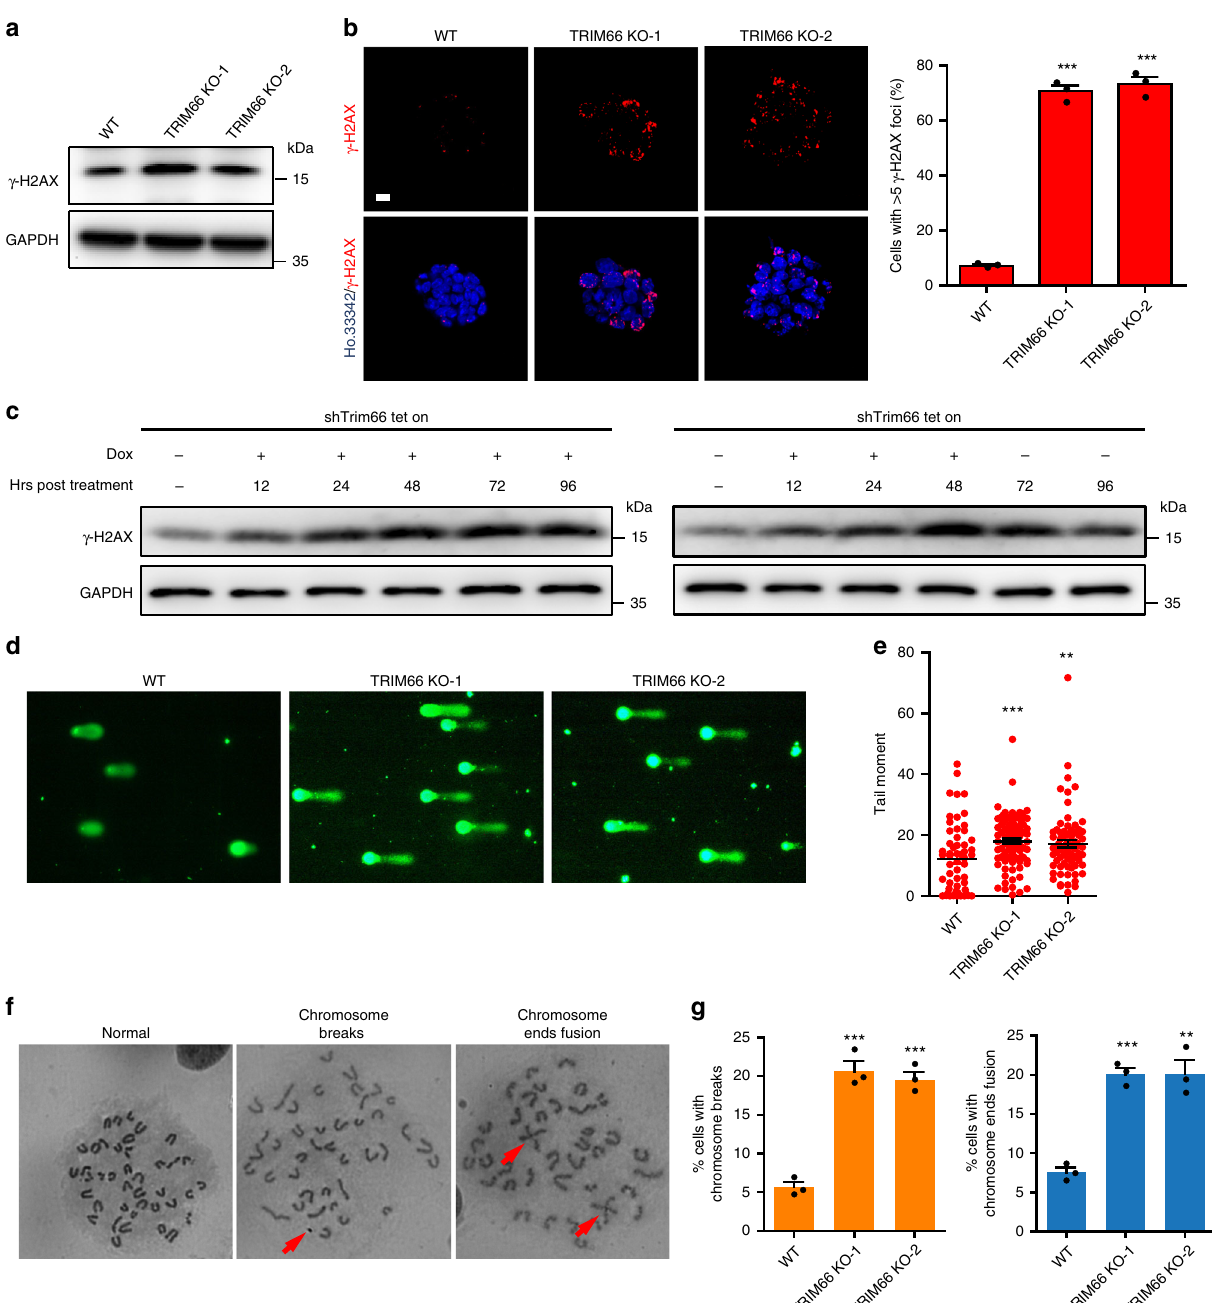
Fig. 3 Loss of TRIM66 leads to severe DNA damage and genomic instability in ESCs. a Immunoblot analysis showing the levels of γ -H2AX in WT and TRIM66-KO ESCs. b The formation of γ -H2AX foci in WT and TRIM66-KO ESCs. Representative immuno fl uorescence images (left) and the quanti fi cation (right) are shown. Scale bar, 10 μ m. More than 200 cells are examined in each sample. c The levels of γ -H2AX are detected by immunoblot analysis in shTrim66 tet-on ESCs. ESCs are persistently treated with doxorubicin (Dox, 1 µ g/ml) for 96 h (left) or 48 h followed by withdrawal of Dox (right). d Representative comet assay images of WT and TRIM66-KO ESCs. e DNA integrity assessment of WT and TRIM66-KO ESCs by the comet assay in d . More than 100 cells are examined in each sample. f Representative gray-scale images of chromosome metaphase spreads of WT and TRIM66-KO ESCs. Arrowheads in red indicates chromosomal breakage or chromosome ends fusion. g Quanti fi cation of chromosomal breakage (left) or chromosome ends fusion (right) in WT and TRIM66-KO ESCs in f . More than 200 cells are examined in each sample. Data are presented as the means ± SEM. Statistical signi fi cance is determined by two-tailed Student ’ s t -test. ** p < 0.01, *** p < 0.001. Source data are provided as a Source Data fi